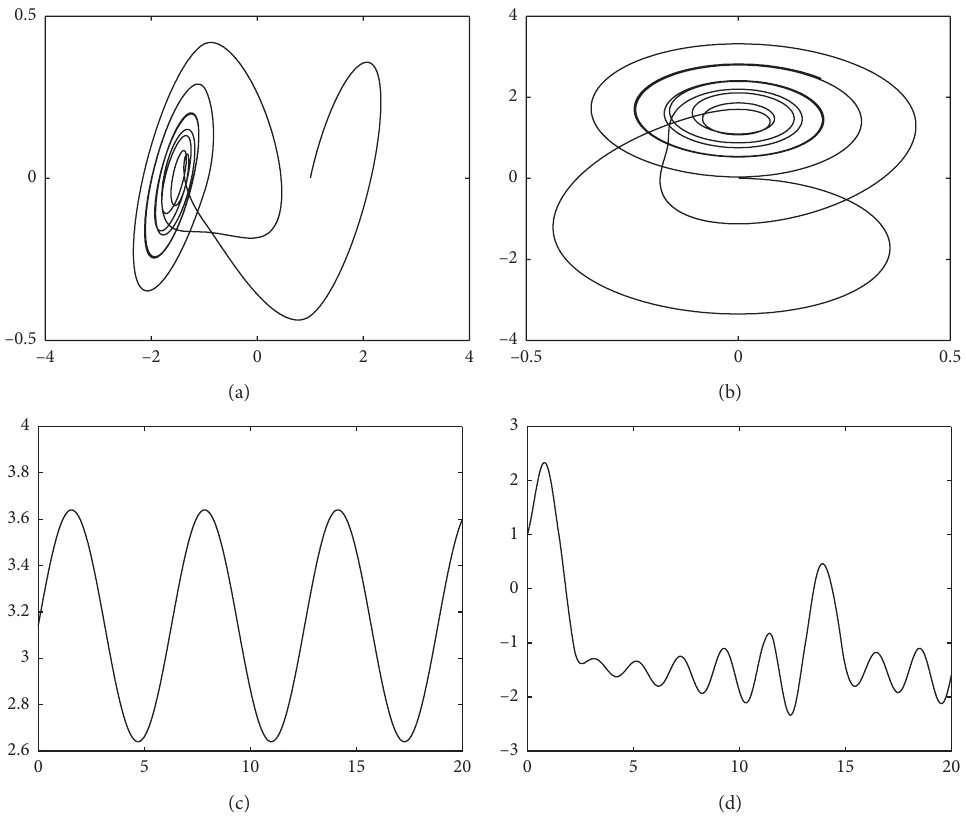
Figure 6: (a) x ( t ) − x ( t ) phase portrait, (b) x 1 2 the continuous-time chaotic system example.